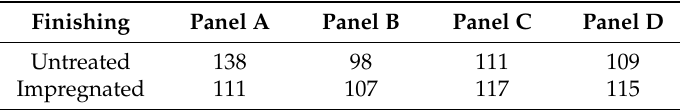
Table 7. Mass gain of panels